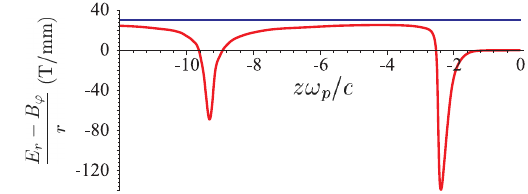
4. (Color) Focusing strength of the plasma wave in the near-axis region. The horizontal line shows the focusing by a uniform ion